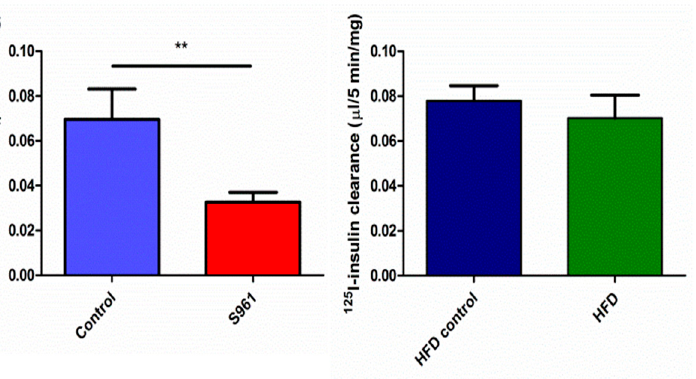
Figure 2. Clearance of radiolabeled insulin by skeletal muscle in rats studied +/- S961 under protocol 1 (left panel) or after feeding a chow diet (blue) or a high-fat diet (green) for four weeks (right panel). ** indicates significance ( p <0.01).